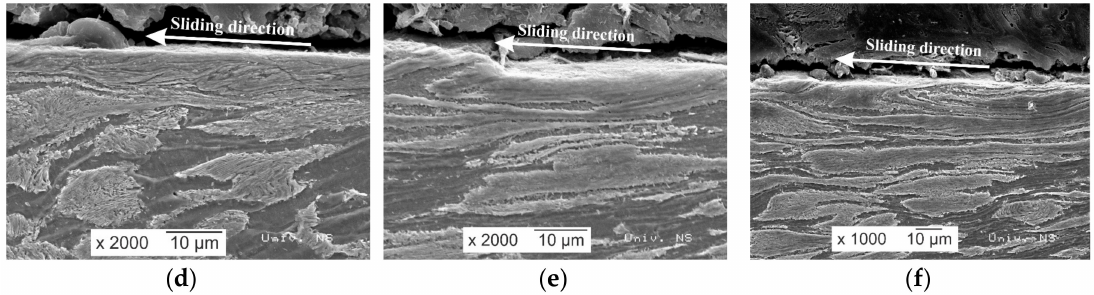
Figure 7. The thickness of the layer of severe plastic deformation after upsetting with the α = 60 deg